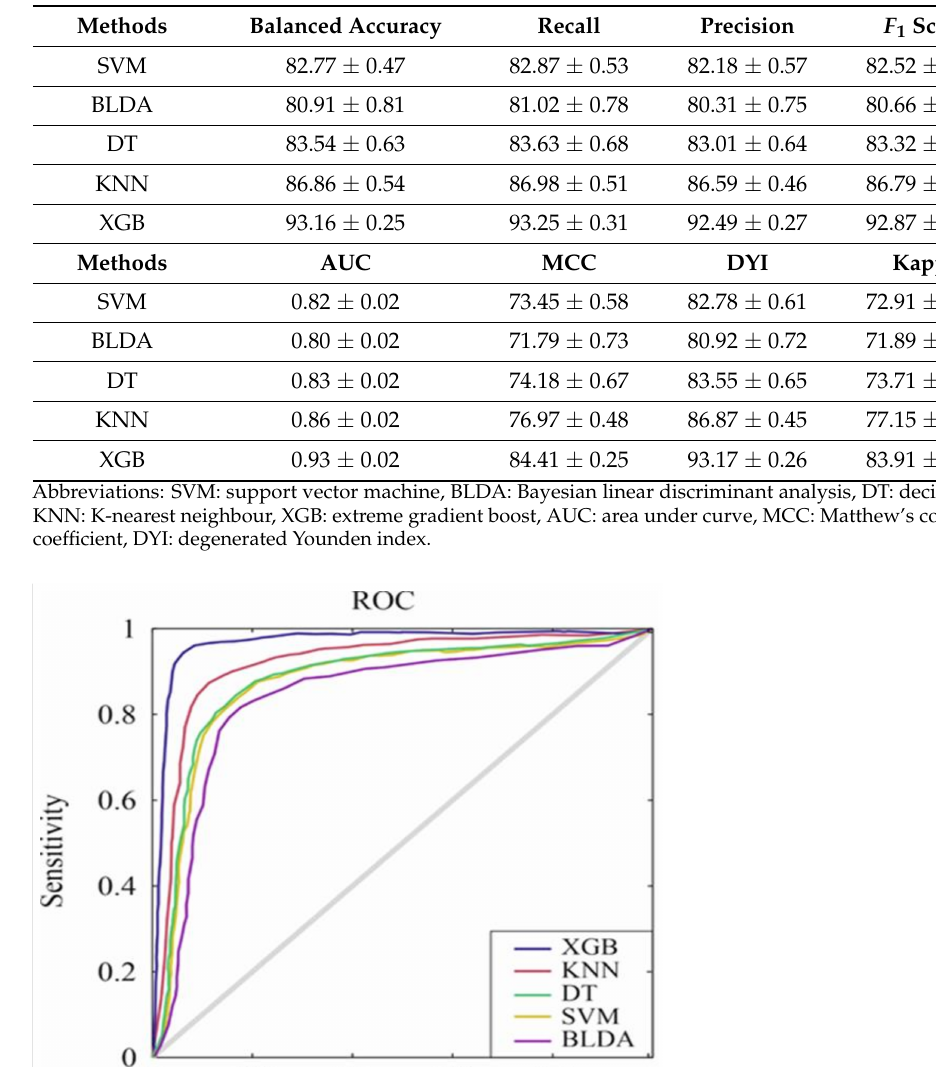
Table 1. Summary of the mean values and standard deviation of balanced accuracy, recall, precision, F 1 score, AUC, MCC, DYI and Kappa index of the machine learning models and the proposed method implemented in this article.